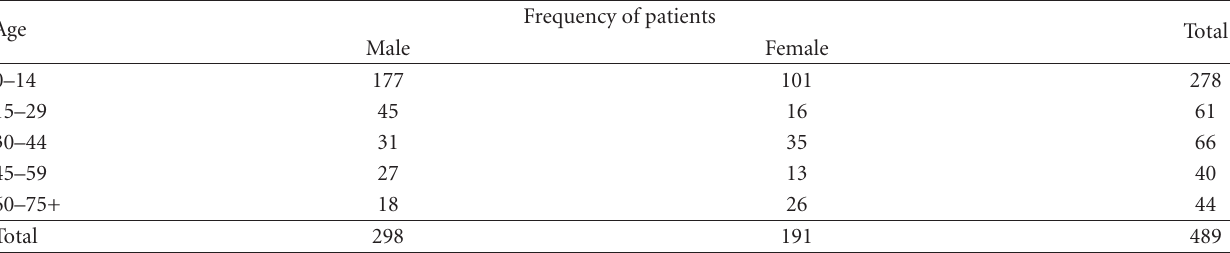
Table 4: Socioeconomic strength of patients in terms of age and gender.